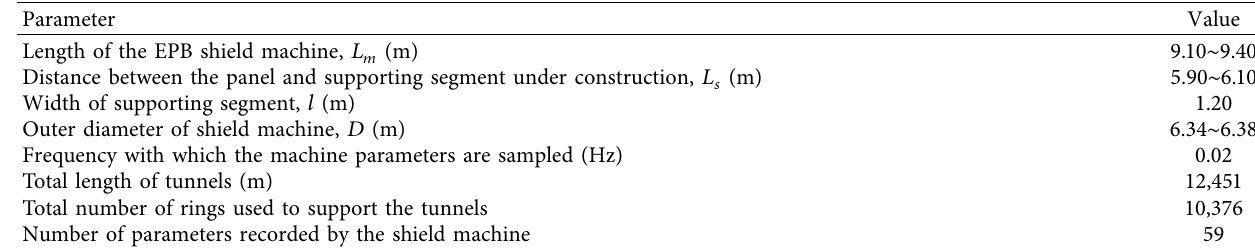
Table 3: Key characteristics of the tunnels/tunneling machine considered in this work. Parameter Value Length of the EPB shield machine, L m (m) Distance between the panel and supporting segment under construction, L s (m) Width of supporting segment, l (m) Outer diameter of shield machine, D